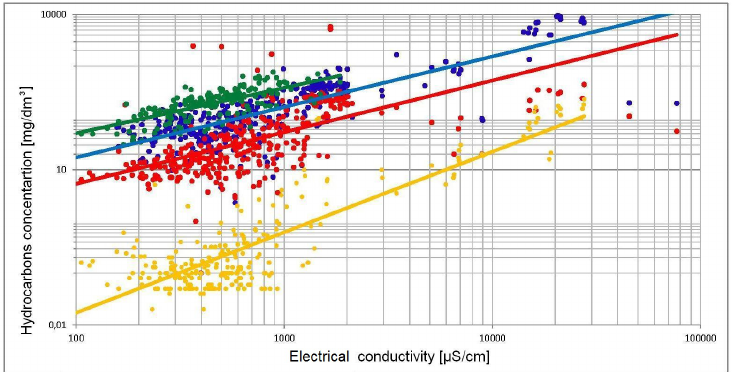
Figure 1. Correlation between EC and hydrocarbons ( ● set of 194 data points), sulfate ( ● set of 380 data points), chlorate ( ● set of 392 data points), ammonium ( ● set of 248 data points).